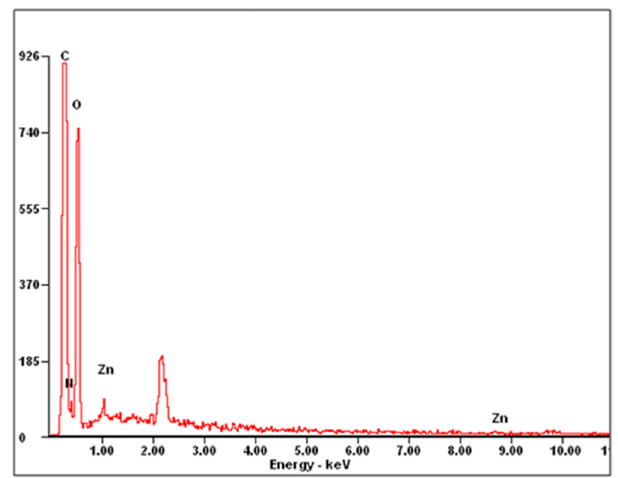
Figure 5. EDS spectrum of hydrogels without pore-forming agents.